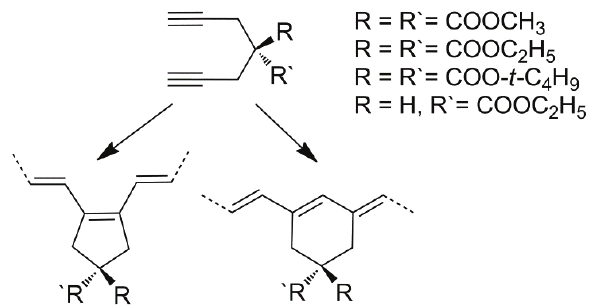
Figure 58. The ring-closure metathesis polymerization of α , ω -dialkynes.